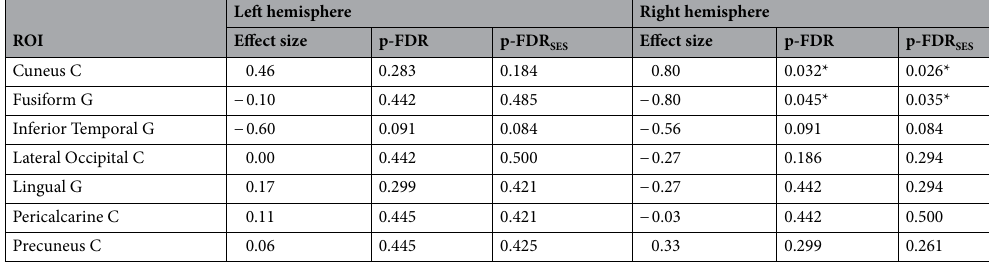
Table 5. Cohen’s d effect sizes and false-discovery rate (FDR) corrected p-values for associations between ScreenQ and sulcal depth for selected regions of interest (ROIs) defined by the Desikan-Killiany cortical atlas and shown in Fig. 4. Negative signs added to effect sizes indicate a negative association between ScreenQ score and sulcal depth. p-FDR false-discovery rate corrected p -value controlling for age and sex, p-FDR SES false-discovery rate corrected p -value controlling for age, sex and socioeconomic status, C cortex, G gyrus. *Signifies that p-FDR is less than 0.05, defined as statistically significant (p-FDR < 0.10 is defined as marginally statistically